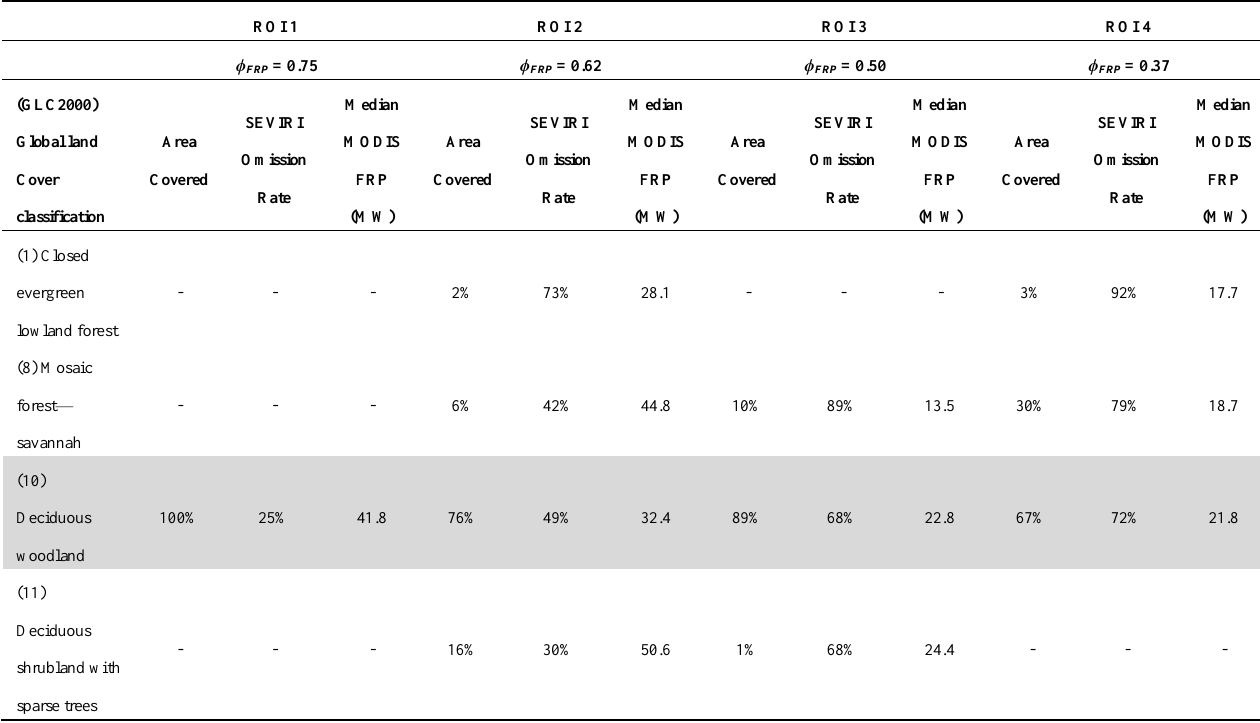
Table 3. Seasonal SEVIRI errors of omission within each region of interest (ROI) depicted in Figure 1a between 1 October 2008 and 30 April 2009 stratified according to the Global Land Cover (GLC2000) database [64].